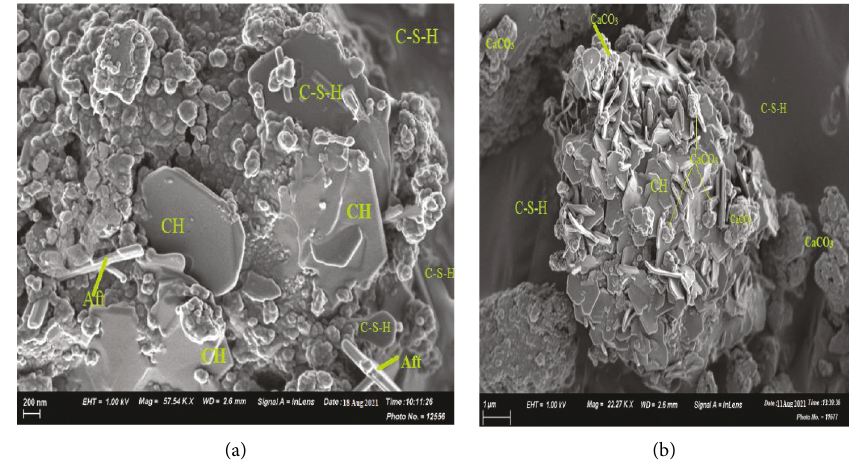
Figure 1: OPC cured with distilled water (a) and OPC cured with Lysinibacillus sphaericus solution